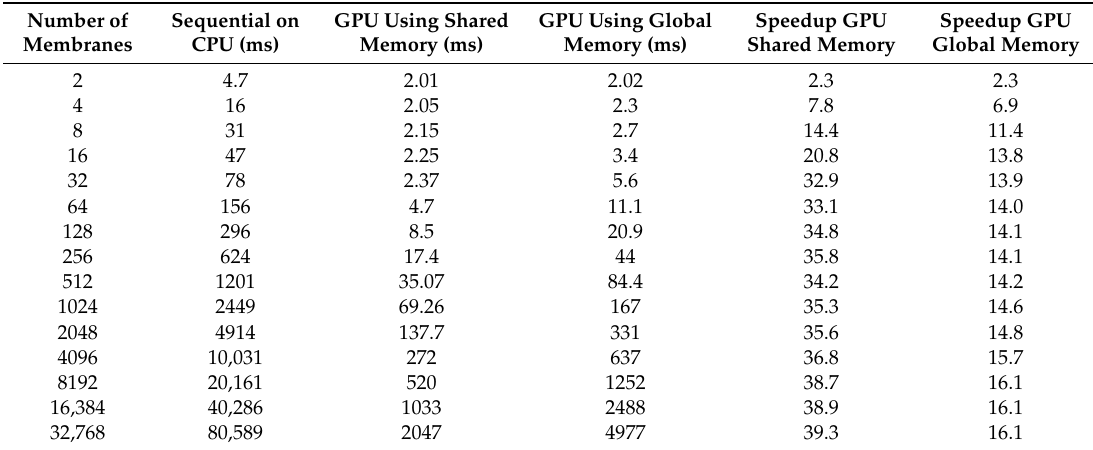
Table 3. Comparison of CPU and GPU performance for di ff erent numbers of membranes for a model with 512 objects